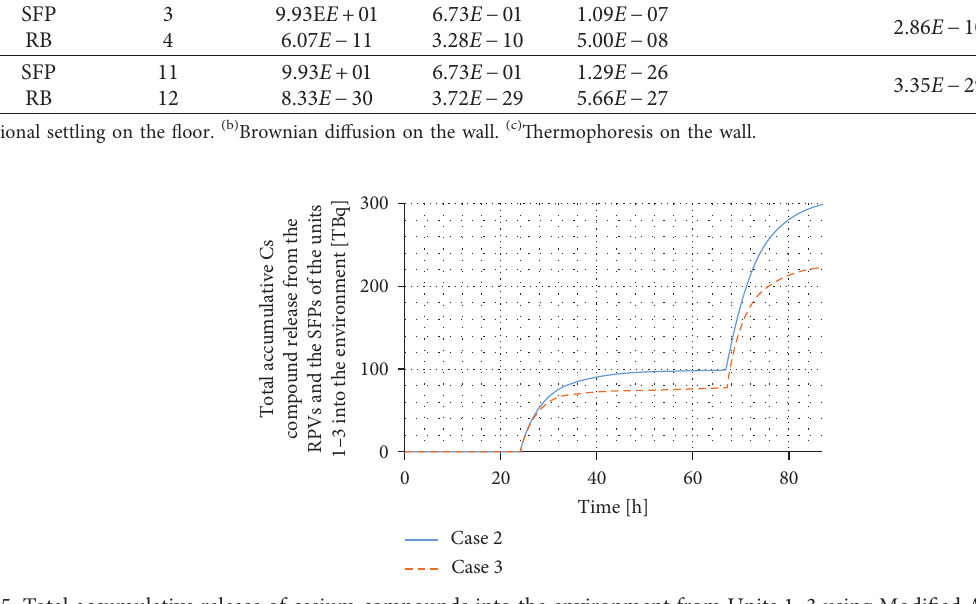
Figure 15: Total accumulative release of cesium compounds into the environment from Units 1–3 using Modified ART Mod 2 of case 3 comparing to case